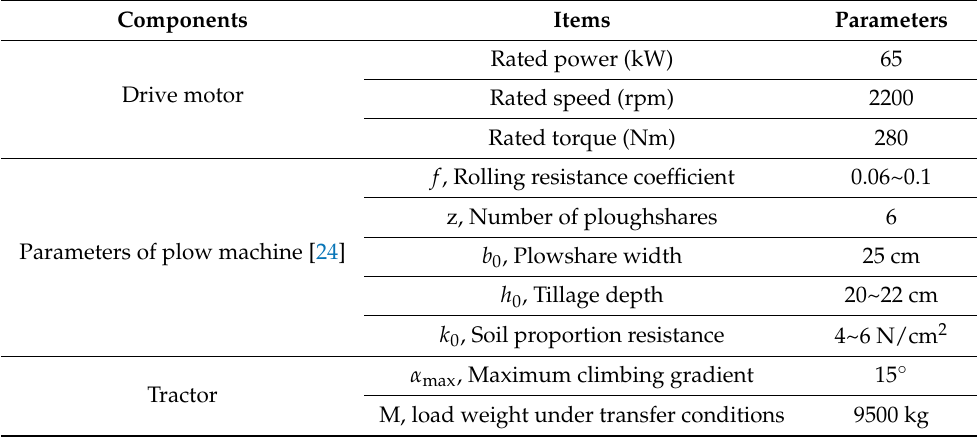
Table 2. The main parameters of plow operation mode. Components Items Parameters Rated power Drive motor